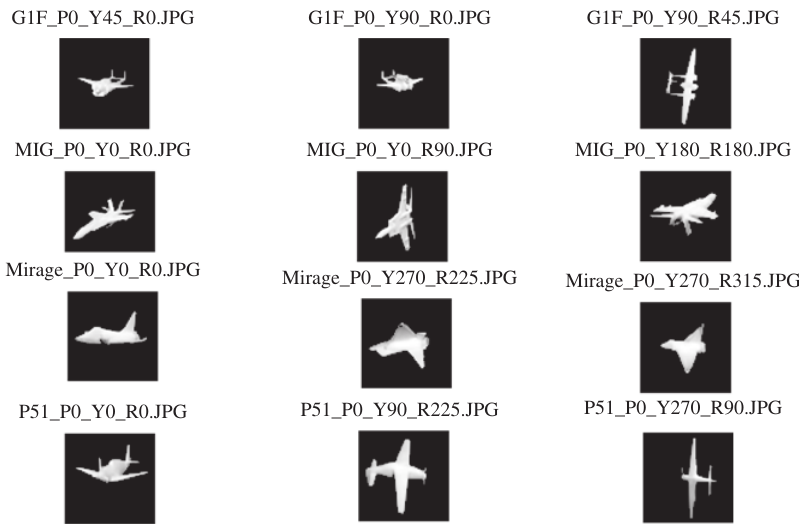
Figure 2: Segmented Training